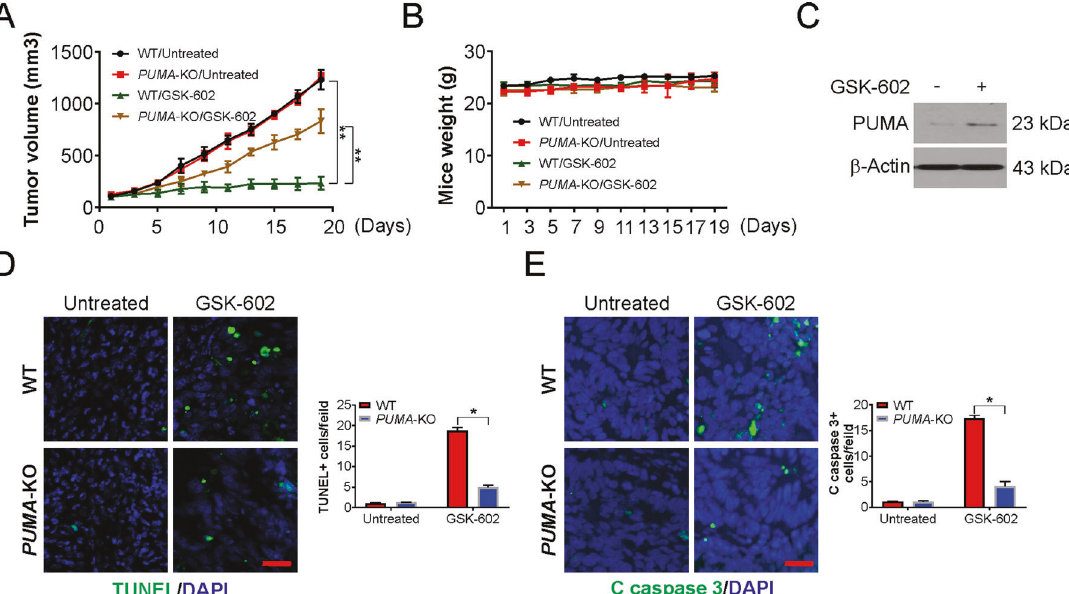
Fig. 4 PUMA is required for the antitumor effects of BRD9 inhibition. A Nude mice were injected s.c. with 5 × 10 6 WT or PUMA -KO GIST-882 cells. After 7 days, mice were treated with 10 mg/kg GSK602 or the vehicle control for 10 consecutive days. Tumor volume at indicated time points after treatment was calculated and plotted with p values, n = 6 in each group. B Mice weight after treatment. C Mice with WT GIST- 882 xenograft tumors were treated with 10 mg/kg GSK602 or the vehicle as in ( A ) for 4 consecutive days. The level of PUMA in three randomly selected tumors were analyzed by Western blotting. D Paraf fi n-embedded sections of WT or PUMA -KO tumor tissues from mice treated as in ( C ) were analyzed by TUNEL staining. Left , representative TUNEL staining pictures; Right , TUNEL-positive cells were counted and plotted, Scale bar: 25 μ m. E Tissue sections from ( D ) were analyzed by active caspase 3 staining. Left , representative staining pictures; Right , active caspase 3-positive cells were counted and plotted, Scale bar: 25 μ m. Results were expressed as means ± SD of three independent experiments. * P <